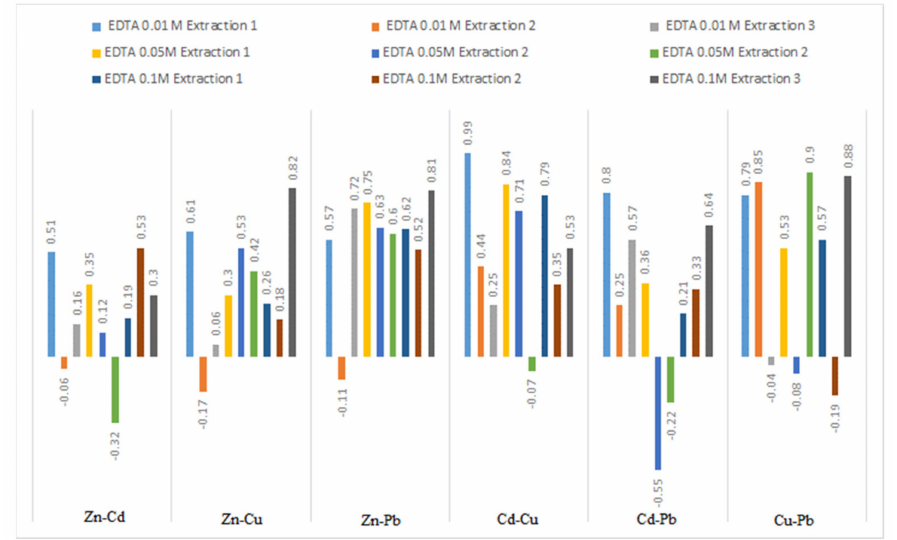
Figure 6. Correlations between trace metals